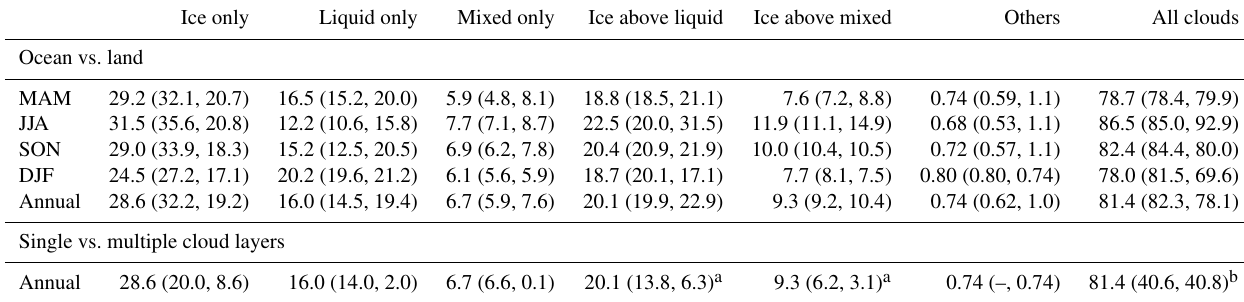
Single vs. multiple cloud layers a The single and multiple layers represent the overlying ice clouds only. b All single-layer clouds are the summation of single-layer–ice-only (20.0%), liquid-only (14.0%), and mixed-only (6.6%) clouds, while all multilayer clouds include multilayer ice-only (8.6%), liquid-only (2.0%), mixed-only (0.1%), ice-above-liquid (20.1%), ice-above-mixed (9.3%), and other (0.74%)